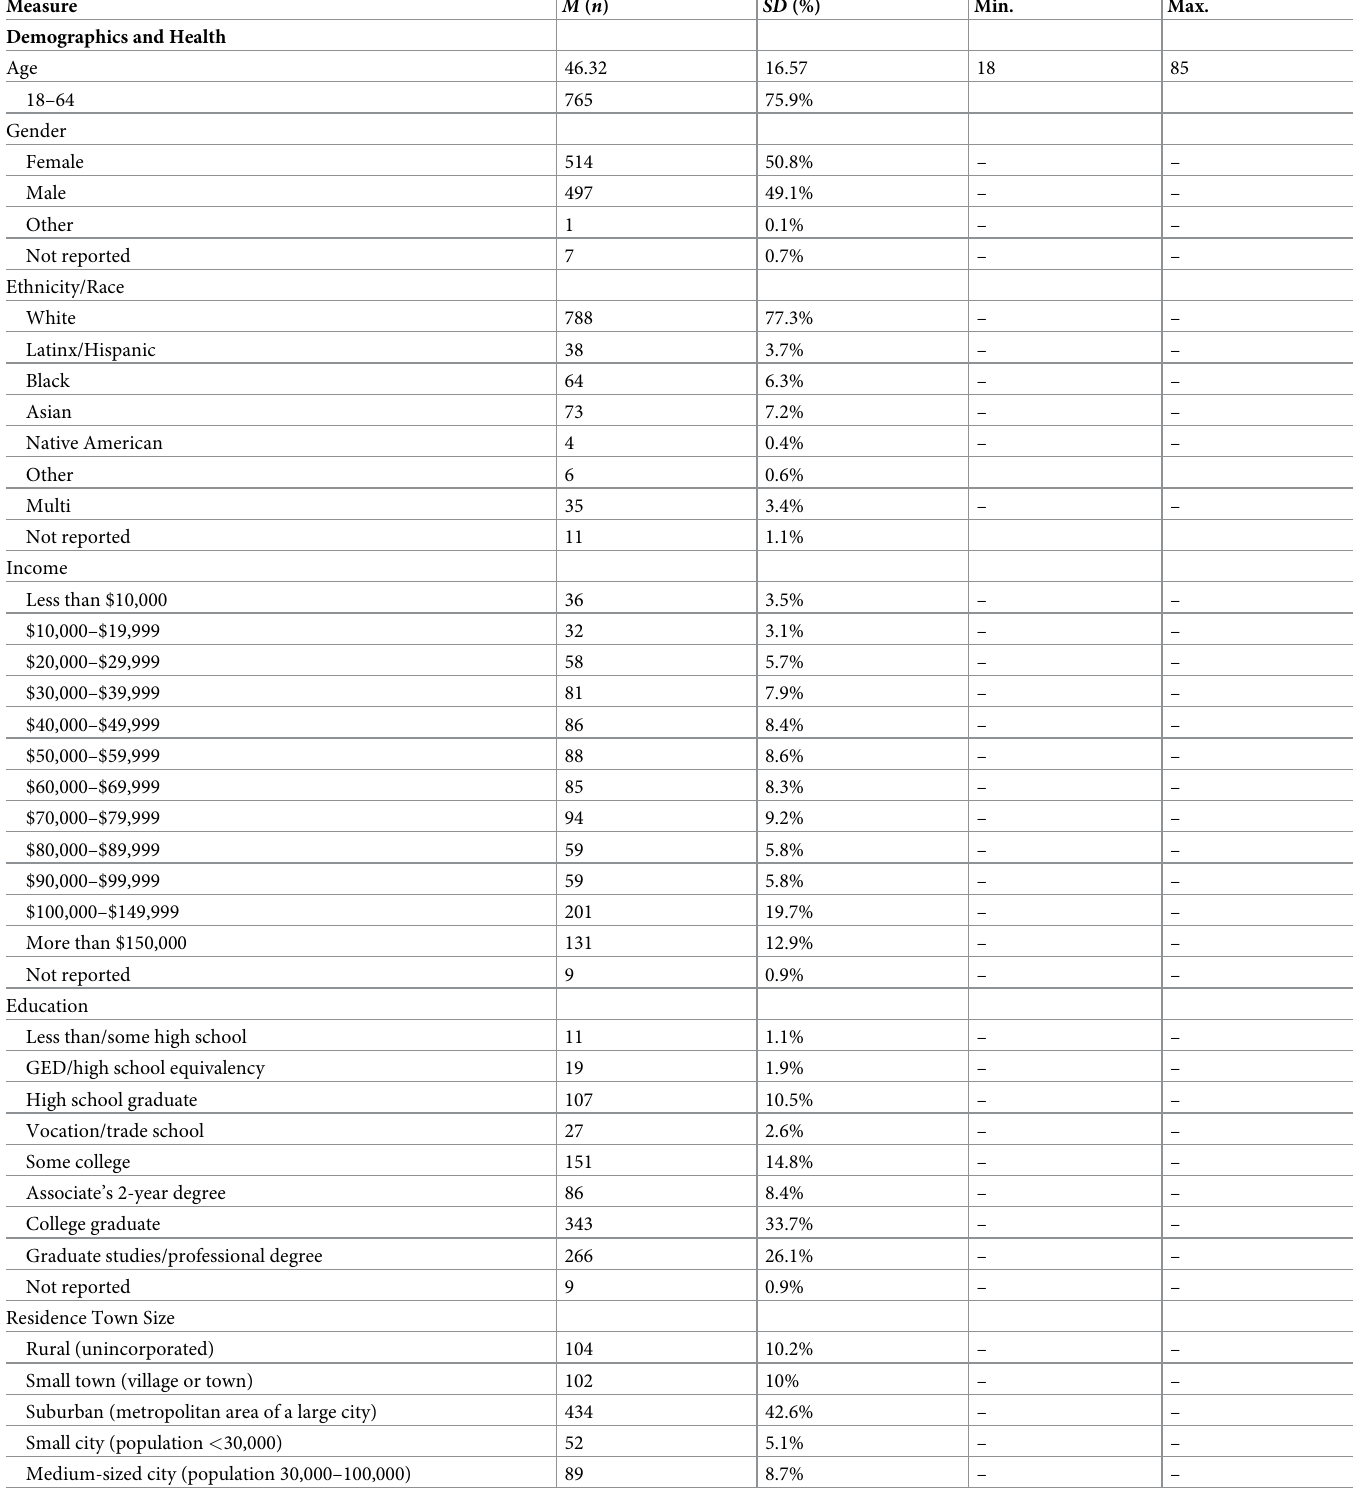
Table 1. Descriptive statistics for all study